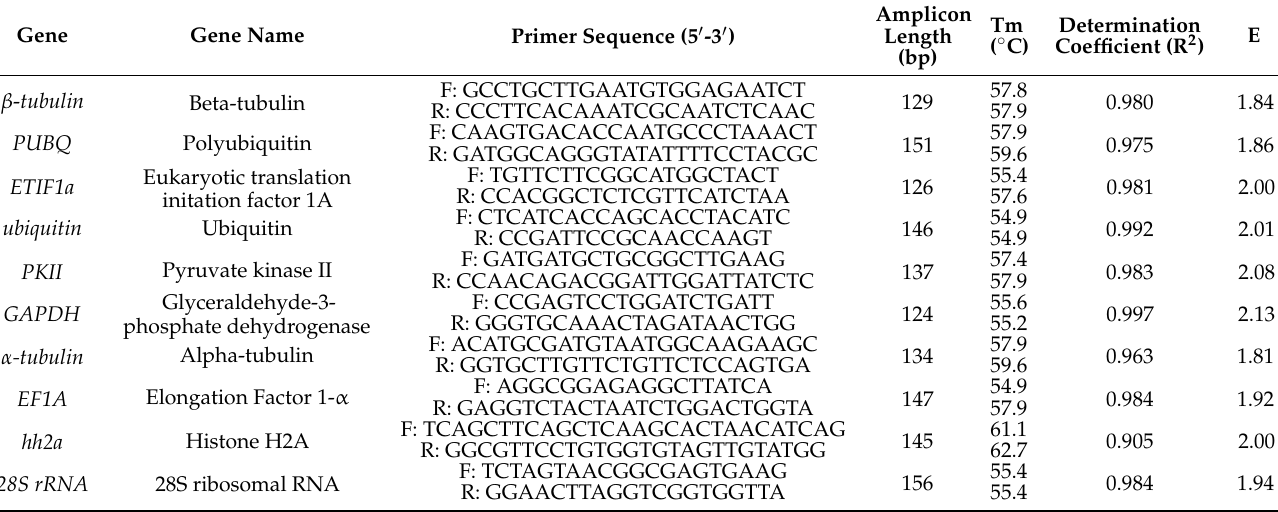
Table 1. Primer information and amplification efficiency of 10 candidate reference